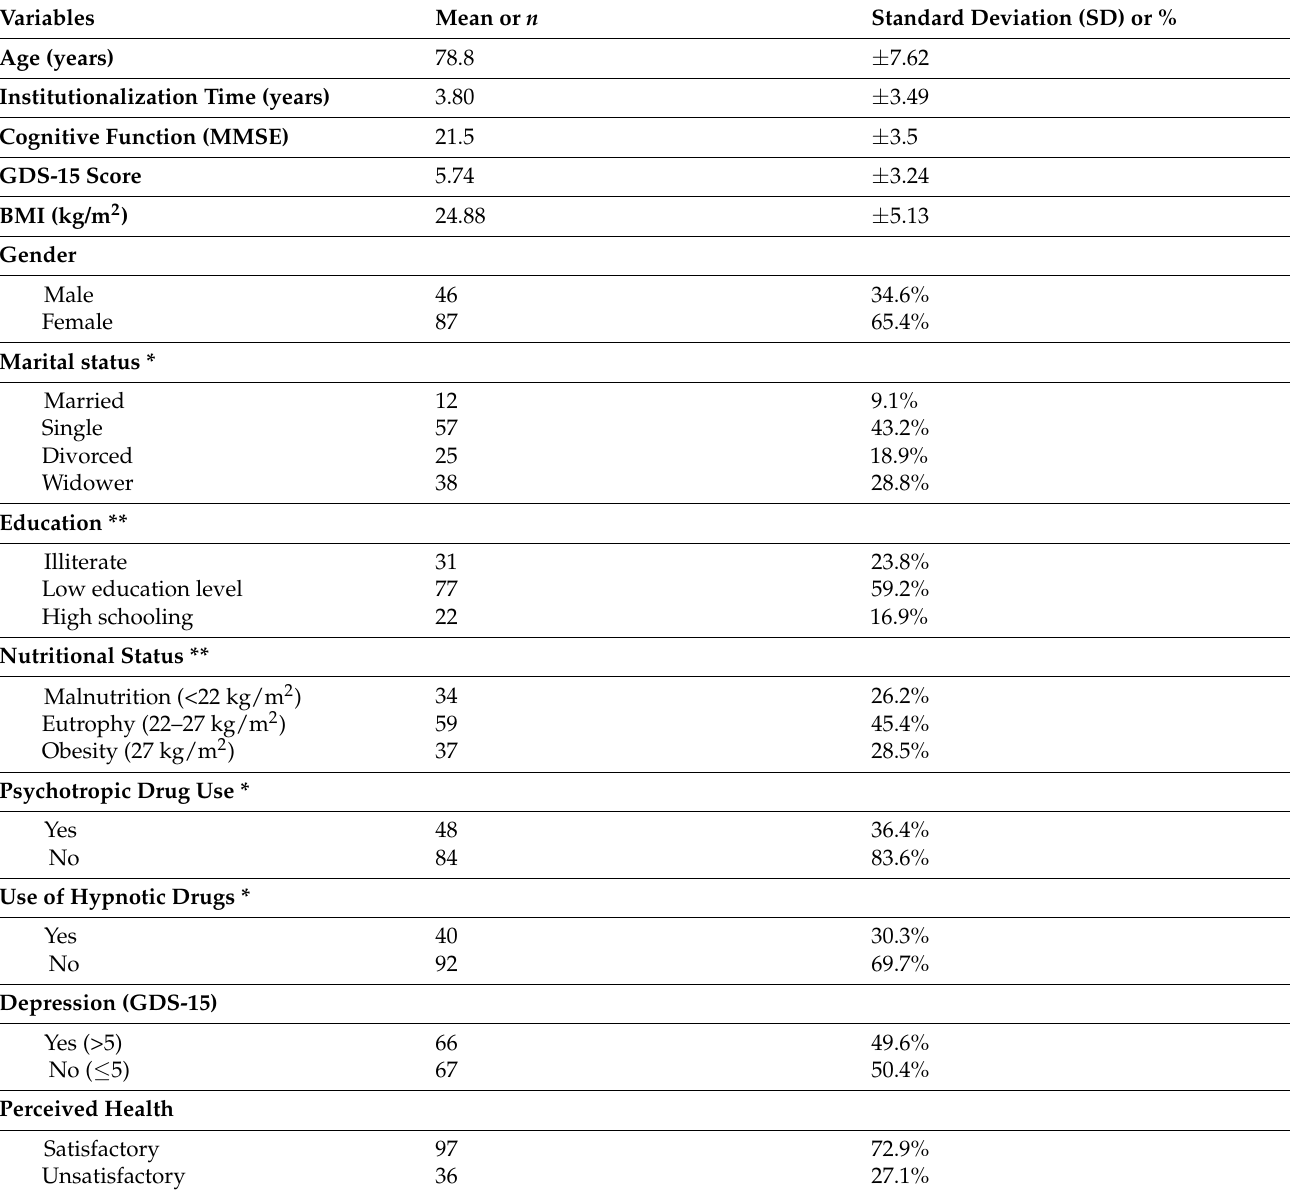
Table 1. Sample Characterization, Natal-RN, 2016 ( n =